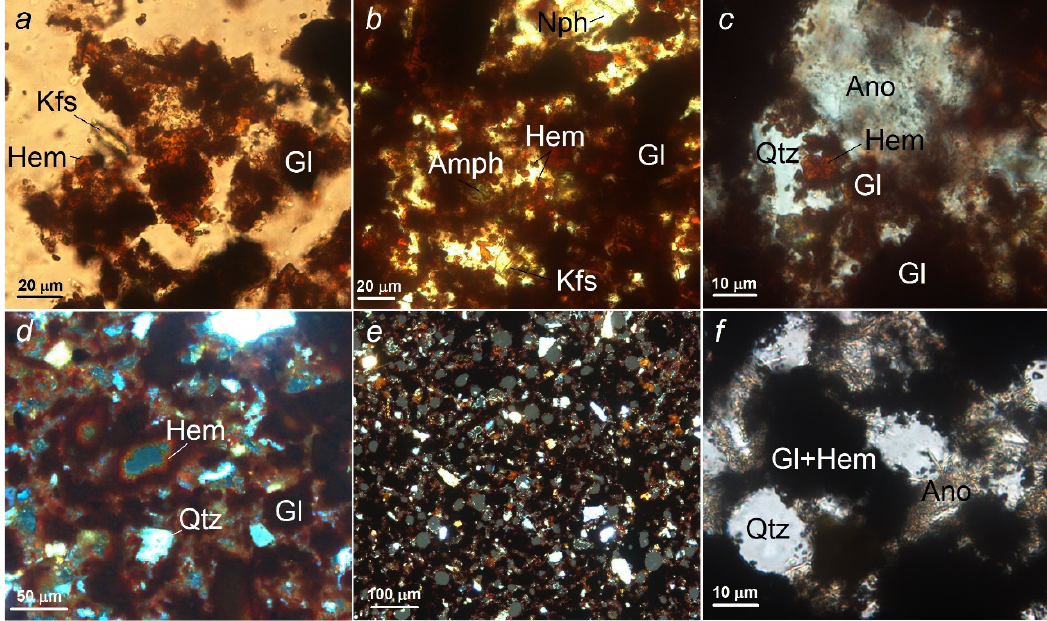
Figure 4. Microphotographs of different samples. ( a,b )—Crystallization of hematite plates in the sample as a result of firing at temperatures of 900 and 950 °C. ( c )—Replacement of quartz and nepheline with anorthoclase in the sample after firing at a temperature of 1000 °C. ( d )—Cavitation (white arrow) surrounded by hematite plates as a result of firing at a temperature of 1050 °C. ( e )—General view of the sample after firing at a temperature of 1100 °C. ( f )—Grey-cavities, anorthoclase development when firing at a temperature of 1100 °C.